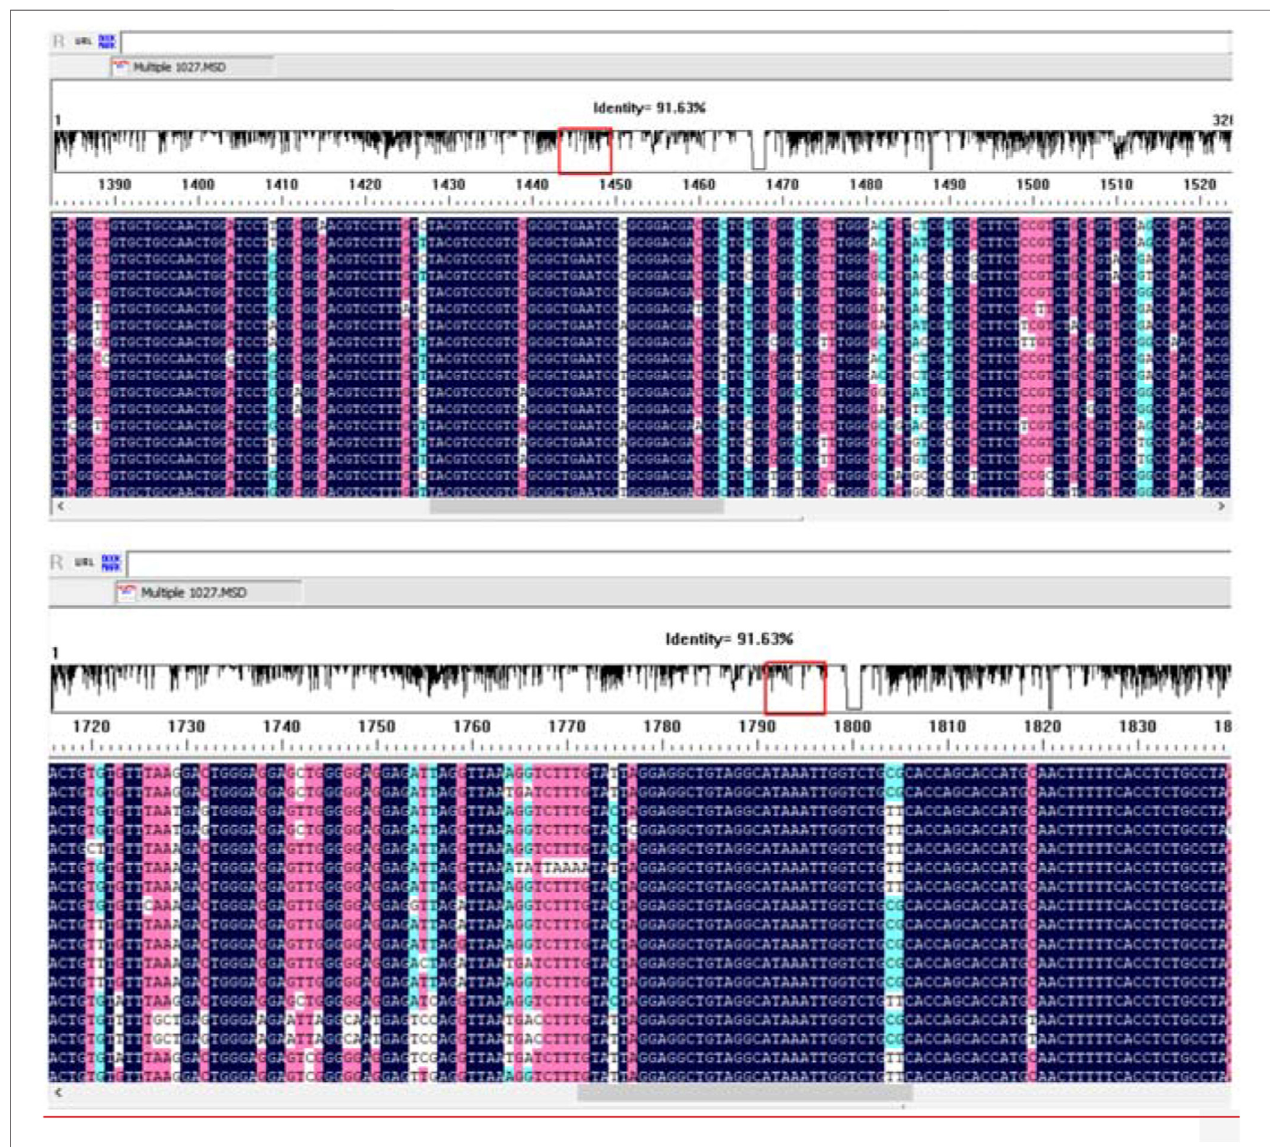
FIGURE 1 | The alignment of 17 hepatitis B virus (HBV) genome sequences using the DNAMAN software.